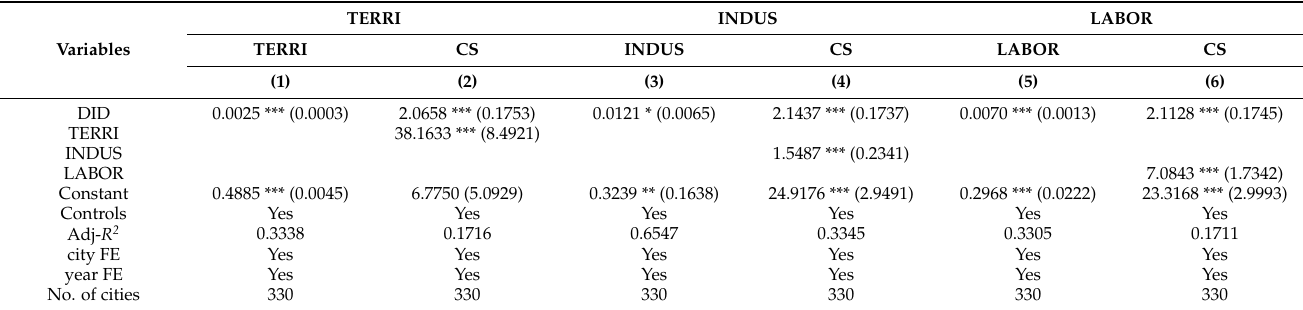
Table 4. The results of mechanism